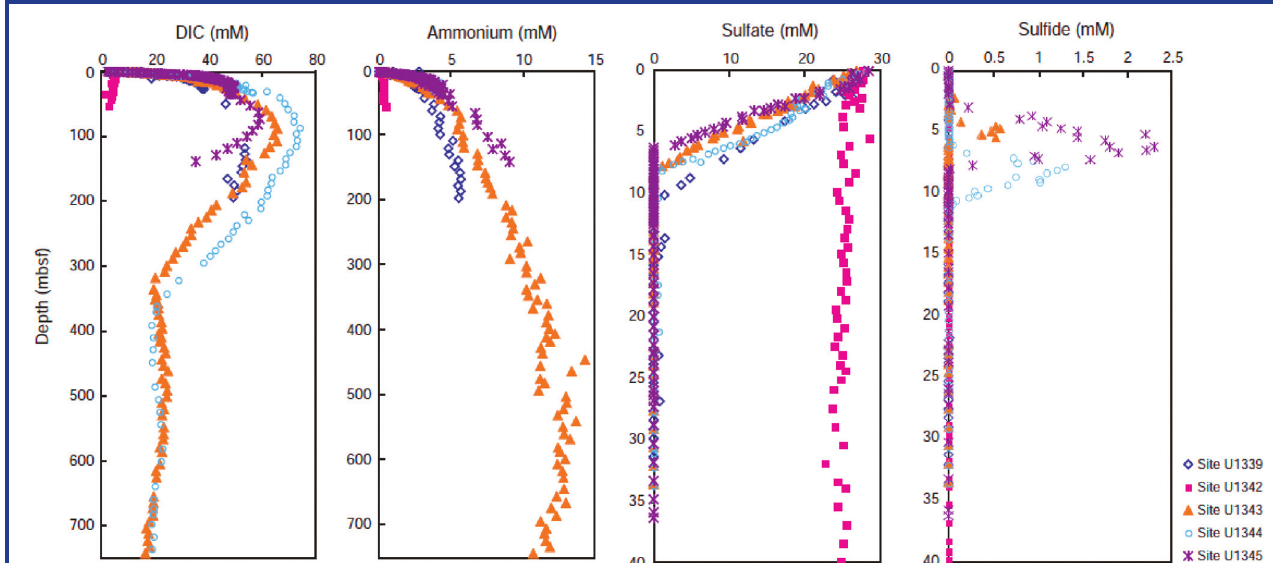
Figure 6. Depth variations in DIC, ammonium, sulfate, and sulfide, illustrating the depth of the SMTZ (~6–11 mbsf) at Sites U1339, U1342, U1343, U1344, and